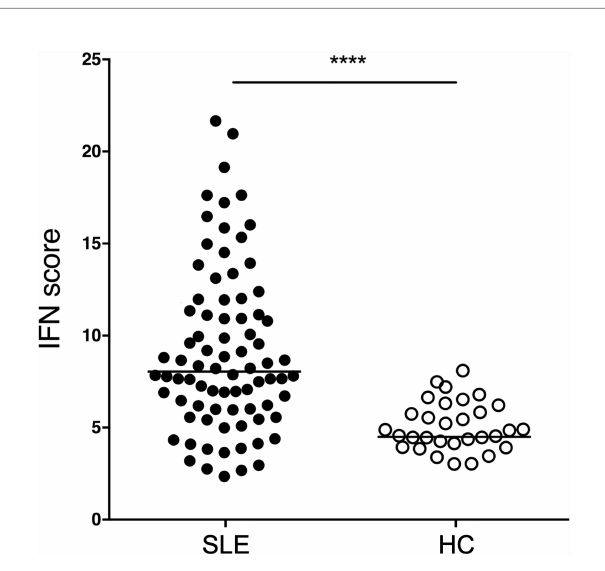
FIGURE 1 | IFN scores of SLE patients and HCs. SLE patients (n=81) and HCs (n=31) were pro fi led for an IFN signature using the transcripts shown in Supplementary Table 1 . p<0.0001. P value was determined by Mann- Whitney test. SLE patients had a median IFN biosignature of 8.0 (IQR